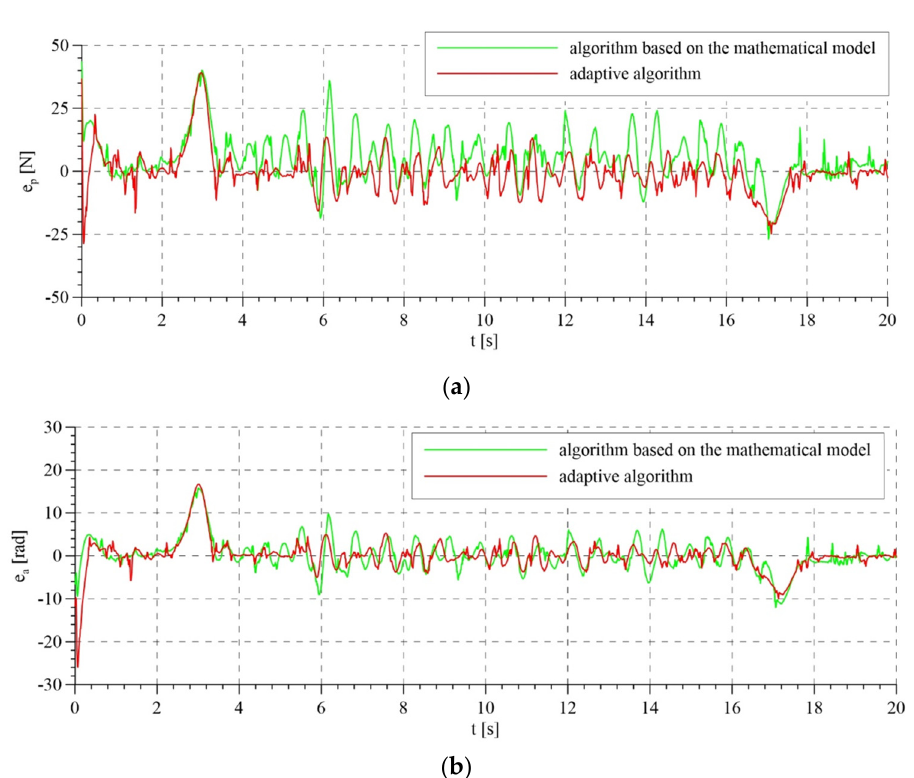
Figure 15. Tracking errors: ( a ) tracking error of the passive part of the system—force error; ( b ) tracking error or the active part of the system—rotation angle error.